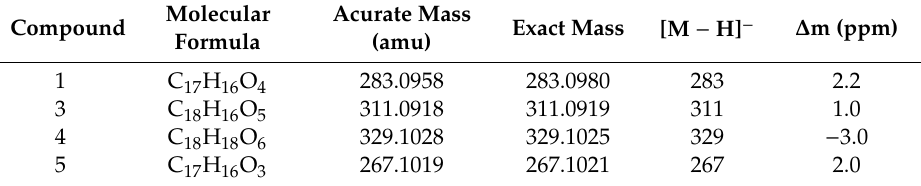
Table 1. Multistage MS n data of chalcones by FIA-ESI/MS ion trap mass spectroscopy.